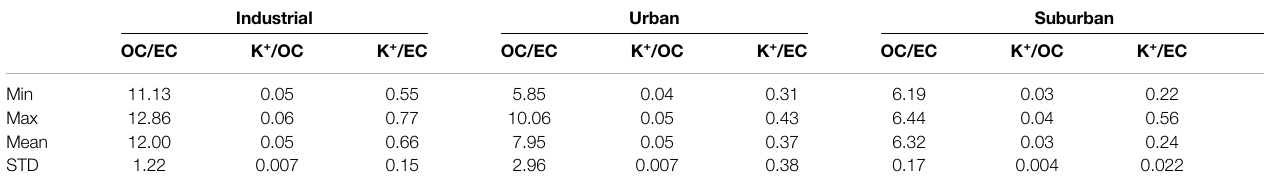
TABLE 1 | Ratio of OC/EC, K + /OC, and K + /EC in three locations of the study area. Industrial Urban Suburban